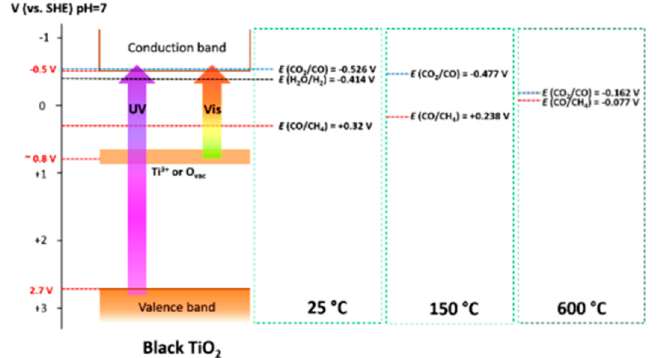
Figure 31. Band structure of TiO 2 , black TiO 2 , and various redox potentials at 25, 150, and 600 °C. Reprinted with permission from [50]. Copyright (2015), American Chemical Society.